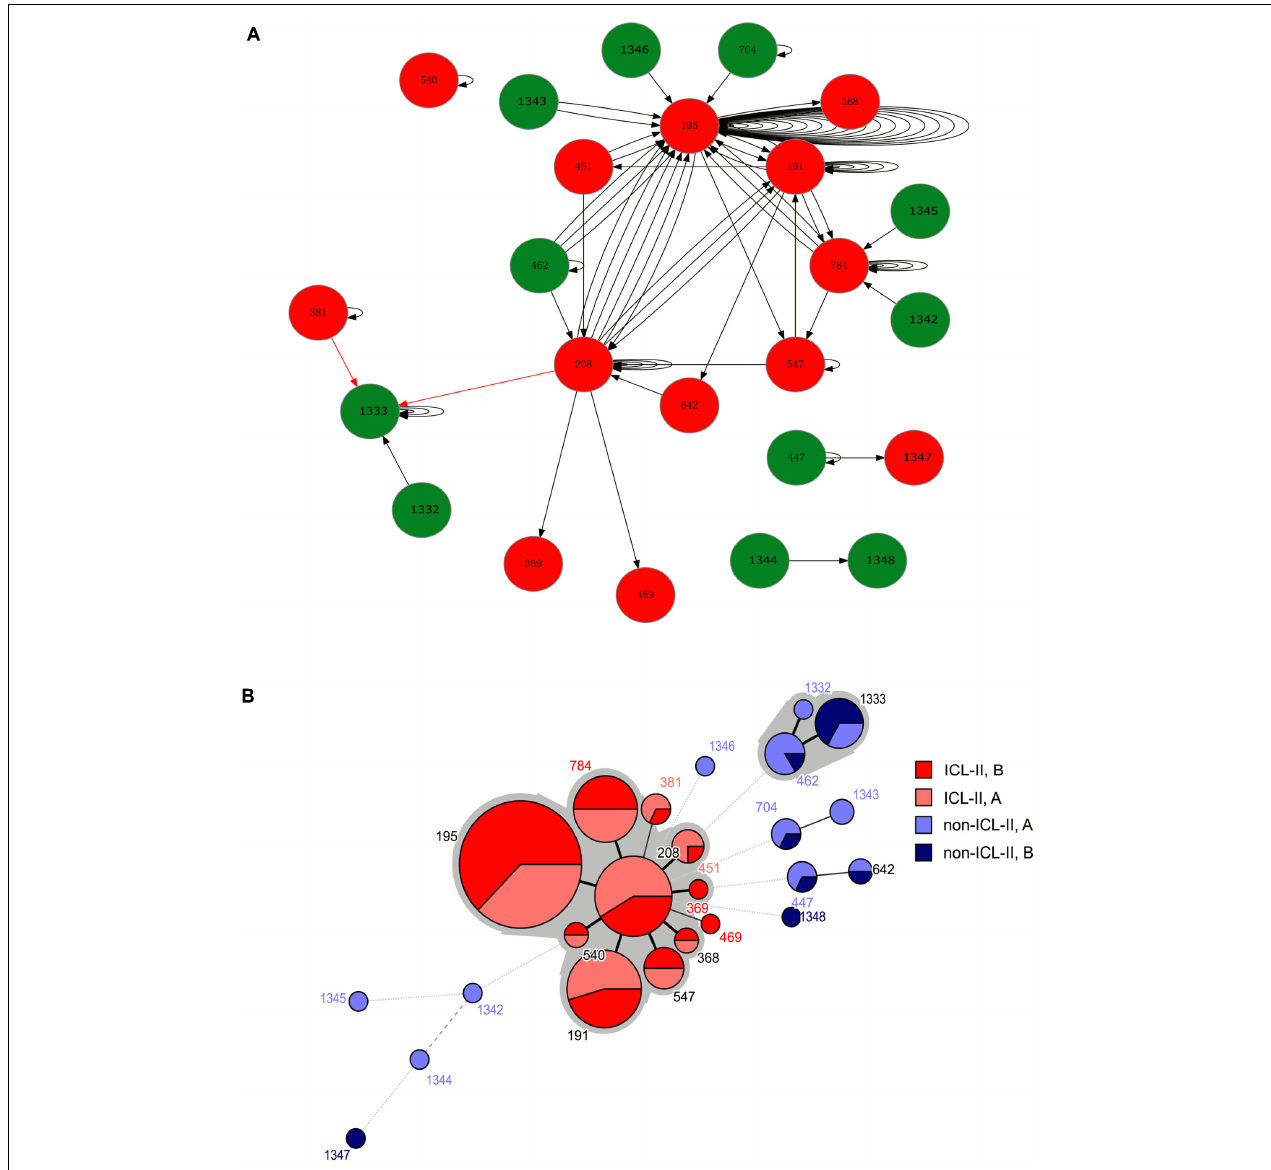
FIGURE 1 | (A) A schematic of A. baumannii within-host evolution. The arrow indicated the alteration of two isolates in one patient. A circle at the head of the arrow indicates that the first isolates in the patients belonged to Group A. A circle at the end of the arrow indicates that the second isolates in the patients belonged to Group B. The black arrow indicates an alteration between the same STs or from non-ICL-II to ICL-II. The red arrow indicated an alteration from ICL-II to non-ICL-II. The number within the circles is the MLST. The color of the circle indicates whether the isolate belonged to ICL-II: Red: ICL-II; Green: non-ICL-II. (B) Minimum spanning tree analysis of all genome-sequenced A. baumannii isolates based on MLST data. Each circle represents an independent ST. The size of each circle indicates the number of isolates. The lines connecting the circles indicate the relationship between different STs. Different types of lines represent the difference in one allele (solid line), two alleles (dashed line), and three or more alleles (dotted lines). Two colored zones surrounding the STs indicate that they belong to the same clonal